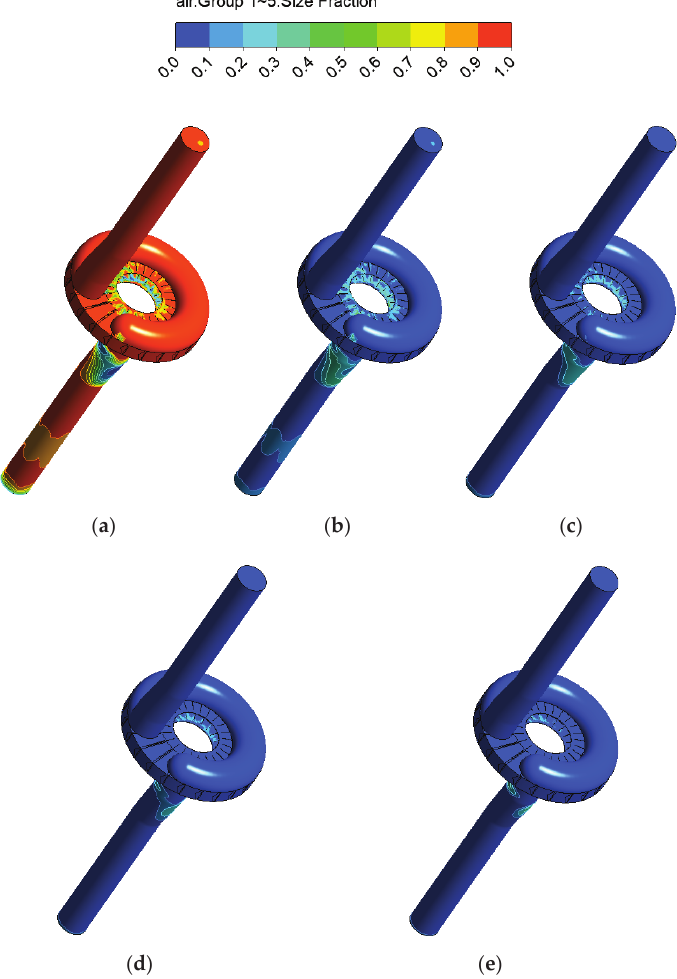
Figure 19. Gas size fraction of different bubble diameters under IGVF 6%. ( a ) group1, ( b ) group2, ( c ) group3, ( d ) group4, ( e ) group5.